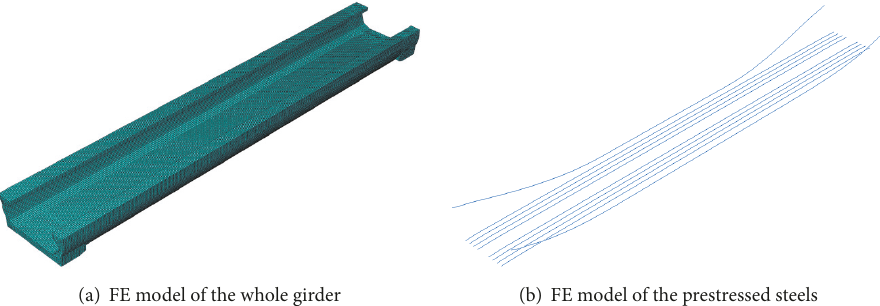
Figure 9: Finite element model for the U-shaped girder.